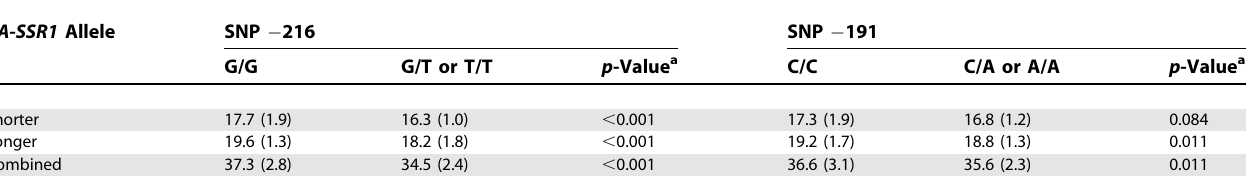
Table 5. The Relationship between Repeat Length of CA-SSR1 and SNPs CA-SSR1